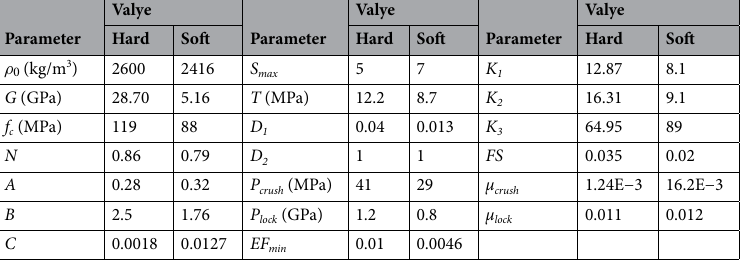
Table 1. Constitutive model parameters of soft and hard rock.